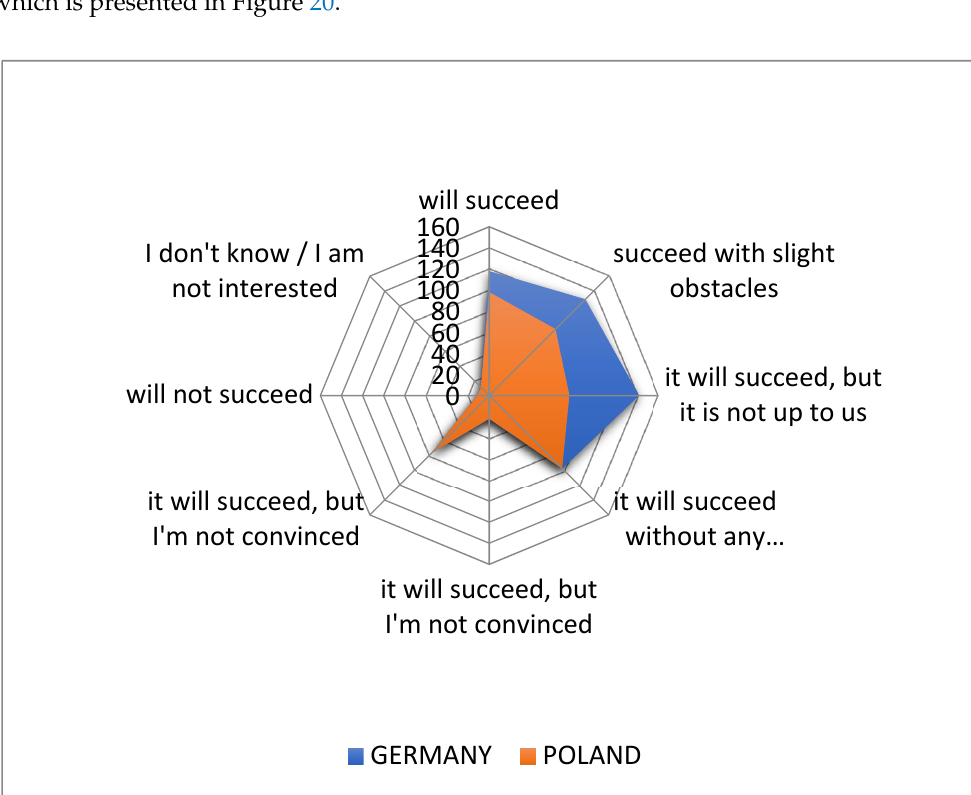
Figure 19. Accepted Success Opportunities.